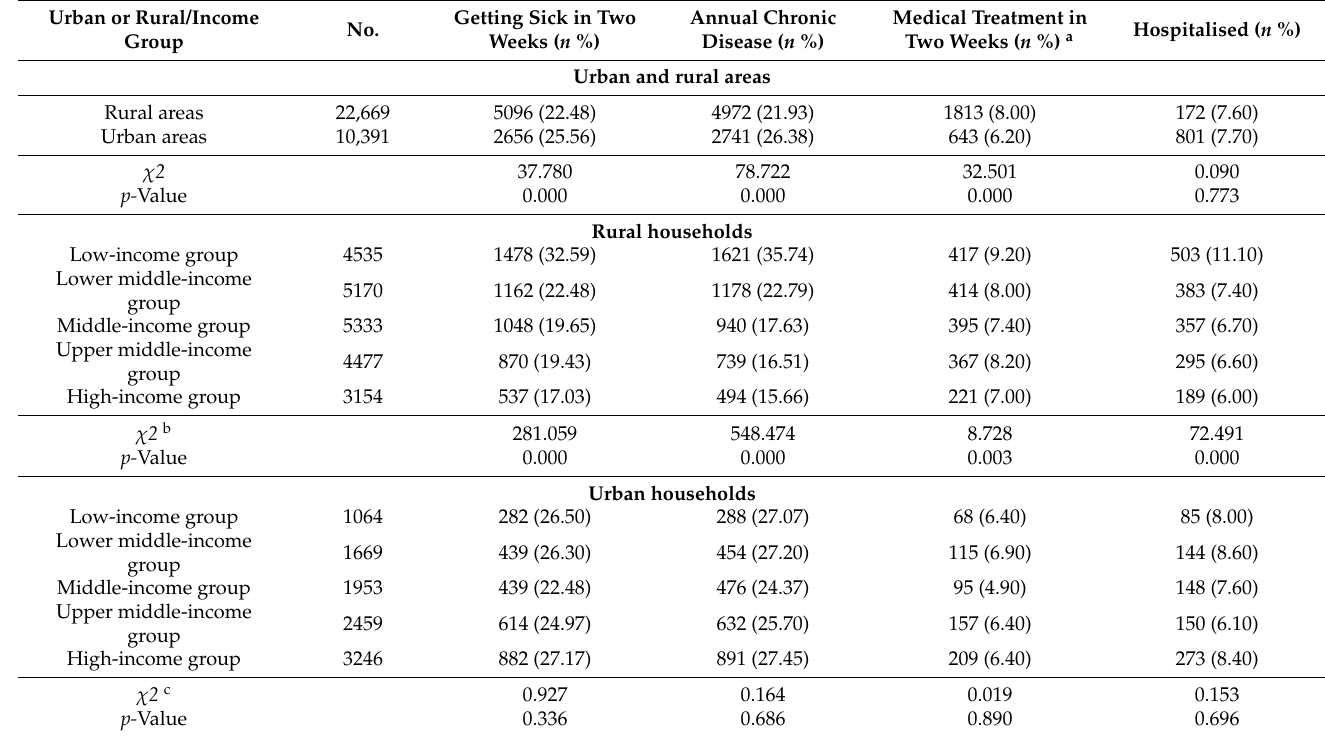
Table 2. Comparisons of health service demand and utilisation among urban and rural residents with different in- come